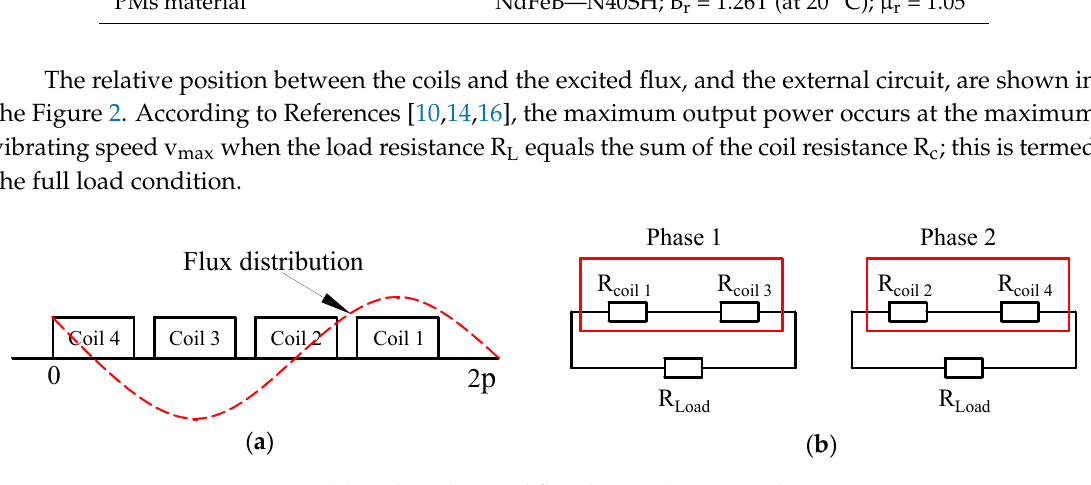
Table 1. Design specifications of the tubular machine with classical Halbach array.